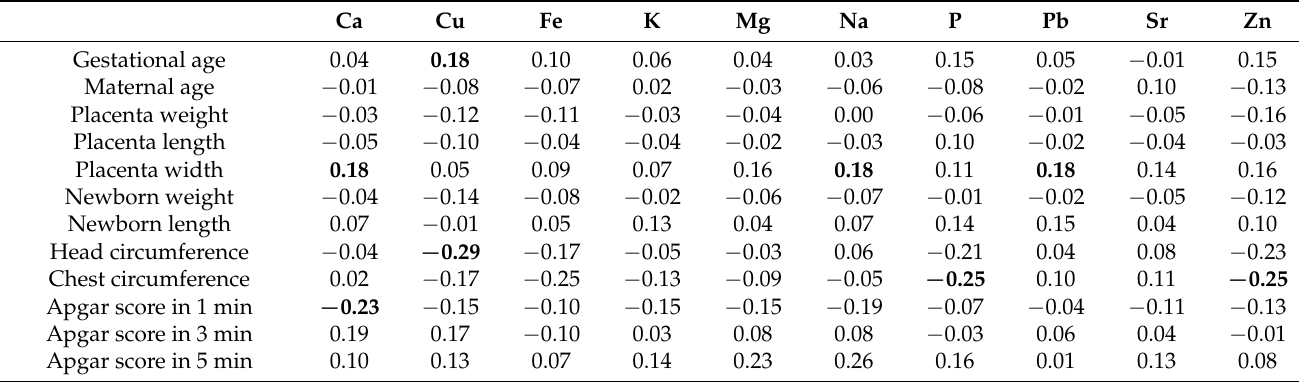
Table 7. Spearman’s rank correlation cofactors between biological parameters of the mother, newborn, and placenta, and the concentrations of Ca, Cu, Fe, K, Mg, Na, P, Pb, Sr, and Zn in the maternal blood (bolded is statistically significant, p < 0.05).